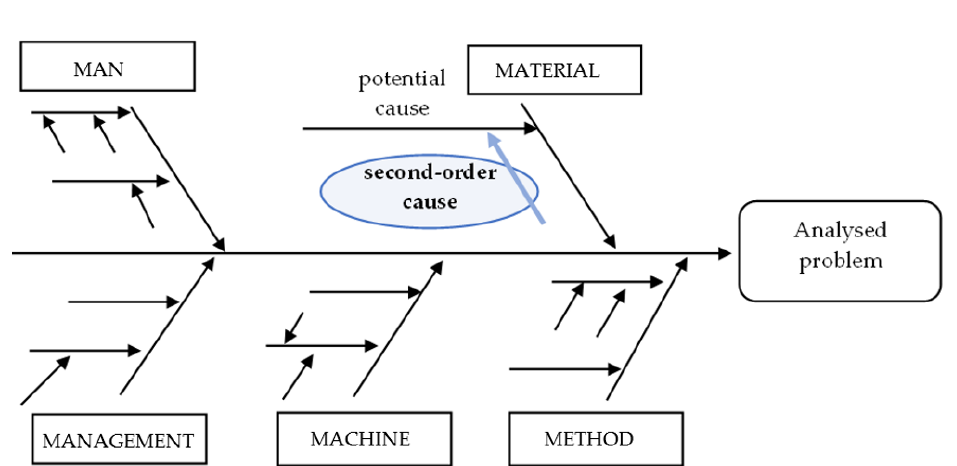
Figure 2. Example of kind of categories and way marked the causes on the Ishikawa diagram with 5M rule (i.e., man, method, material, machine, management).